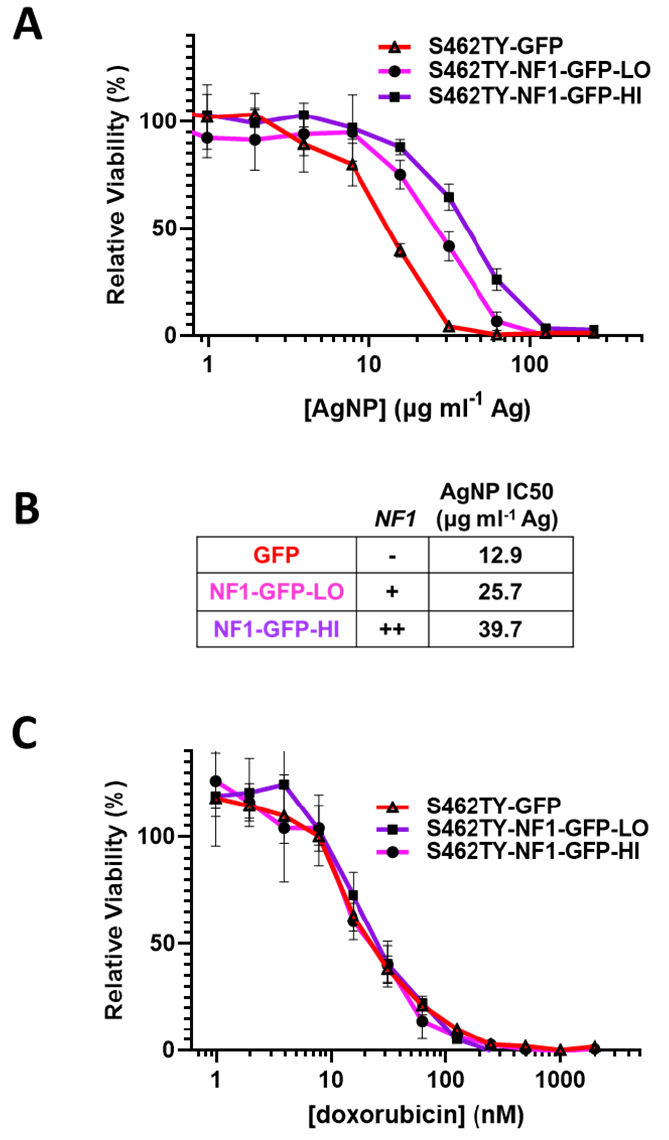
Figure 4. Restoration of functional neurofibromin in NF1-associated MPNST reduces sensitivity to AgNPs, with no change in sensitivity to standard of care doxorubicin. NF1-associated MPNST cell line S462TY was transfected with expression plasmids containing control GFP or two amounts of neurofibromin 1, tagged with GFP (NF1-GFP-Lo, NF1-GFP-Hi) and was puromycin selected. ( A ) Pooled cells were then treated with AgNP (0–250 µ g mL − 1 Ag) for 72 h, and viability was assessed by MTT assay. ( B ) Relative NF1-GFP plasmid levels and IC 50 of AgNP ( µ g mL − 1 Ag) are shown. ( C ) Cells were treated with doxorubicin (0–2000 nM) for 72 h, and viability was assessed by MTT assay. Data are representative of 4 independent experiments, each containing 5 technical